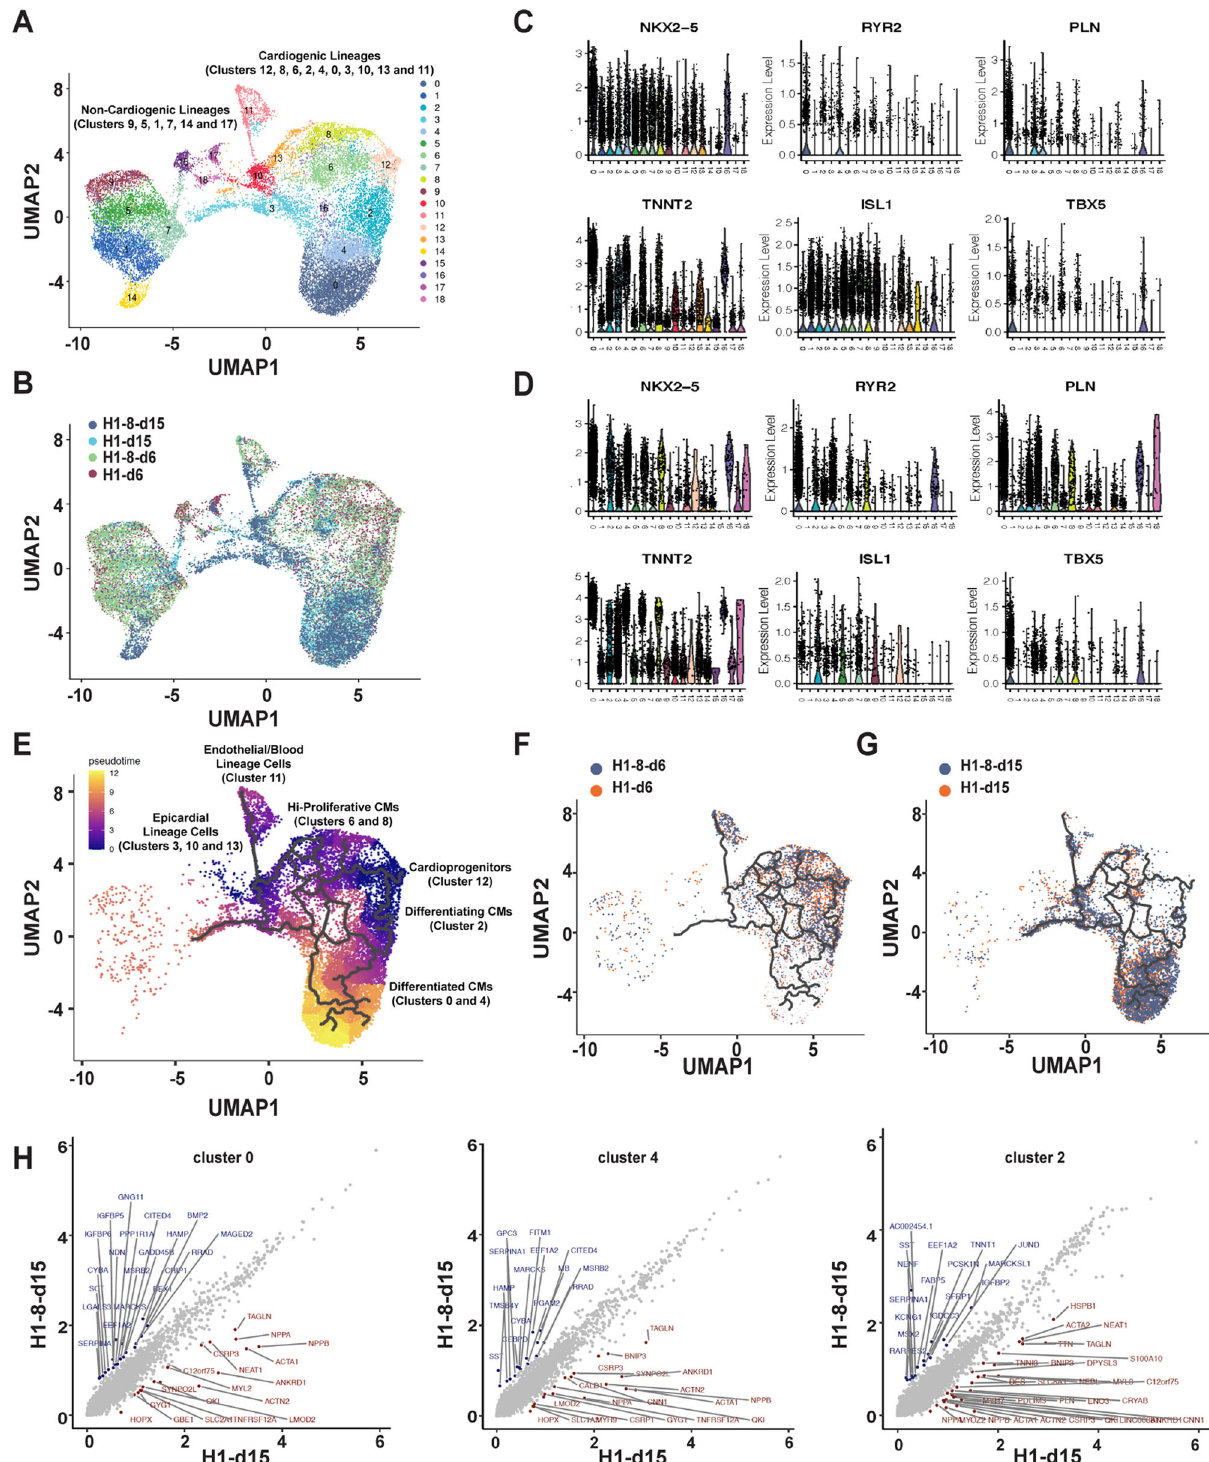
(cluster 2) included genes involved in post-translational protein phosphorylation and cell cycle regulation (Fig. 3H and Supple- mentary Fig. 6B), suggesting a defect in the intracellular signaling. The downregulation of ACTN2 was con fi rmed in Day-15 hCMs- QKI del (Supplementary Fig. 6C). In addition, the ratio of MYH7/ MYH6 in hCMs- QKI del at Day-15 was signi fi cantly lower compared to control hCM (Supplementary Fig. 6C), indicating a defect in the process of functional maturation of